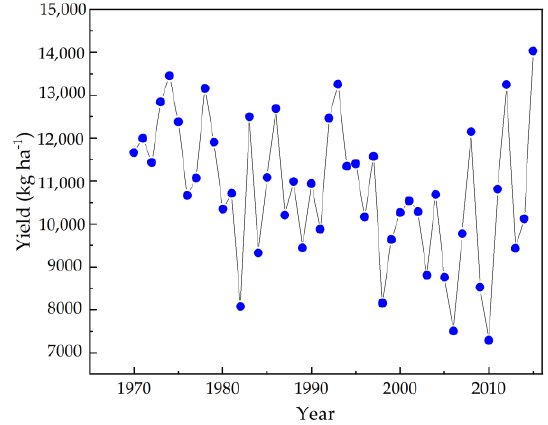
Agronomy 2020 , 10 , x FOR PEER REVIEW Figure 7. Simulated grain yields without the drought stress at the di ff erent growth stages (1970–2015). Figure 7. Simulated grain yields without the drought stress at the different growth stages (1970 – 2015).